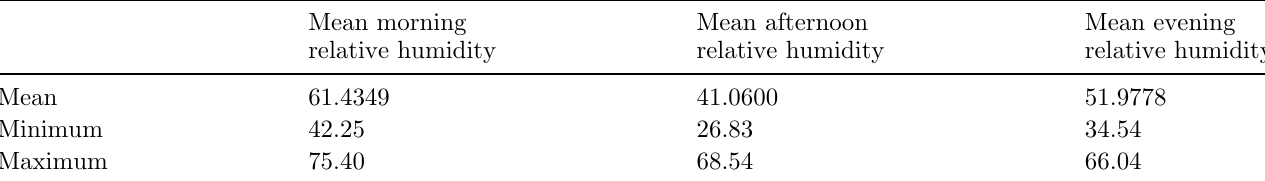
Table 10. Indoor relative humidity values during the dry season.